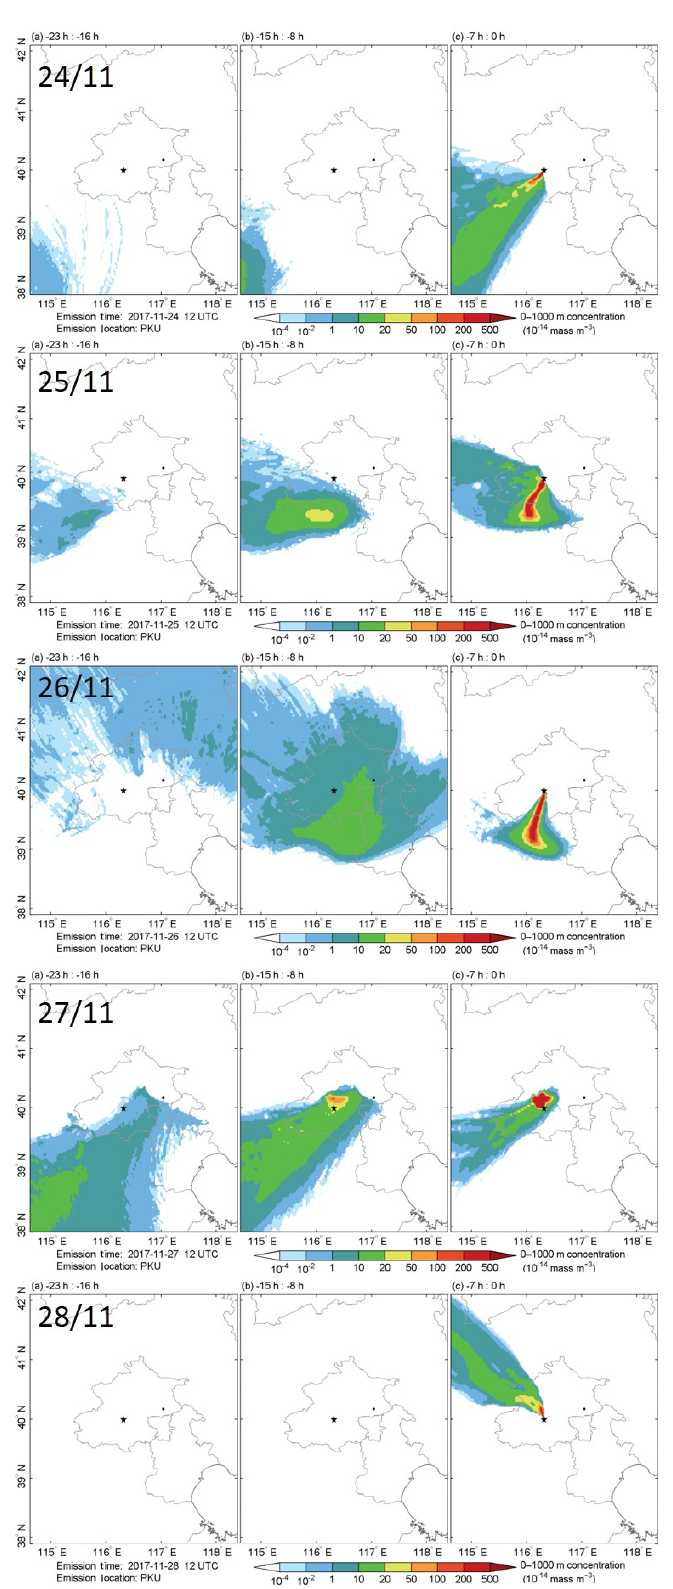
Figure 11. Typical dispersion of air mass from PKU (star on the left) to PG (dot on the right) in E1 (1 November), E2 (11 November), E3 (19 November), and E4 (29